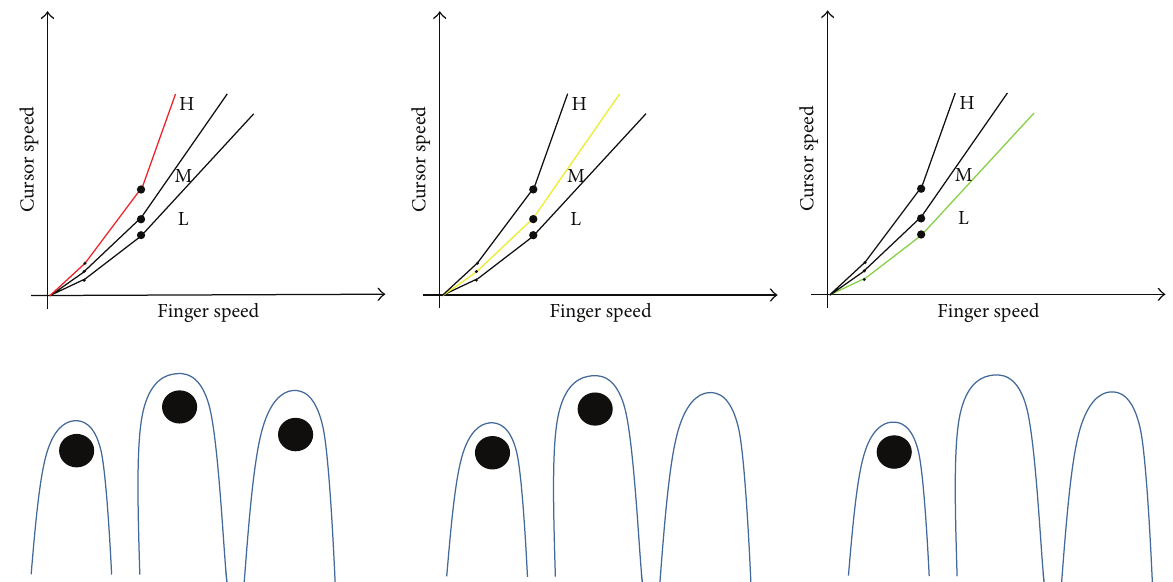
Figure 1: Conceptual image depicting the mechanism of switching pointer acceleration curves by varying the number of fingers in contact with the